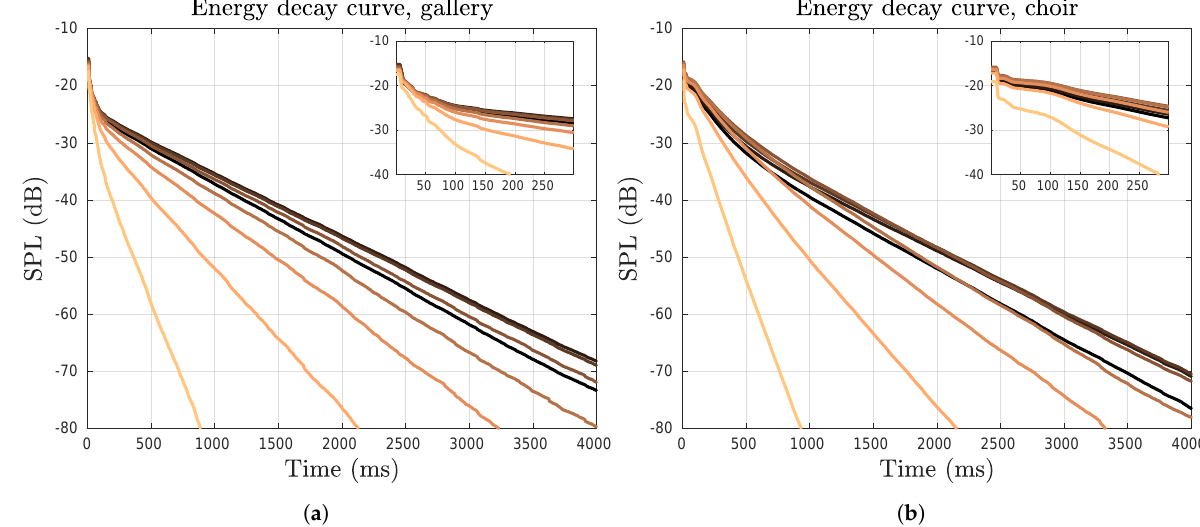
Figure 11. Energy decay curves in the ( a ) nuns’ gallery and ( b ) monks’ choir in the reconstructed abbey. The small insets show the early parts of the decay. Each line corresponds to the results in one octave